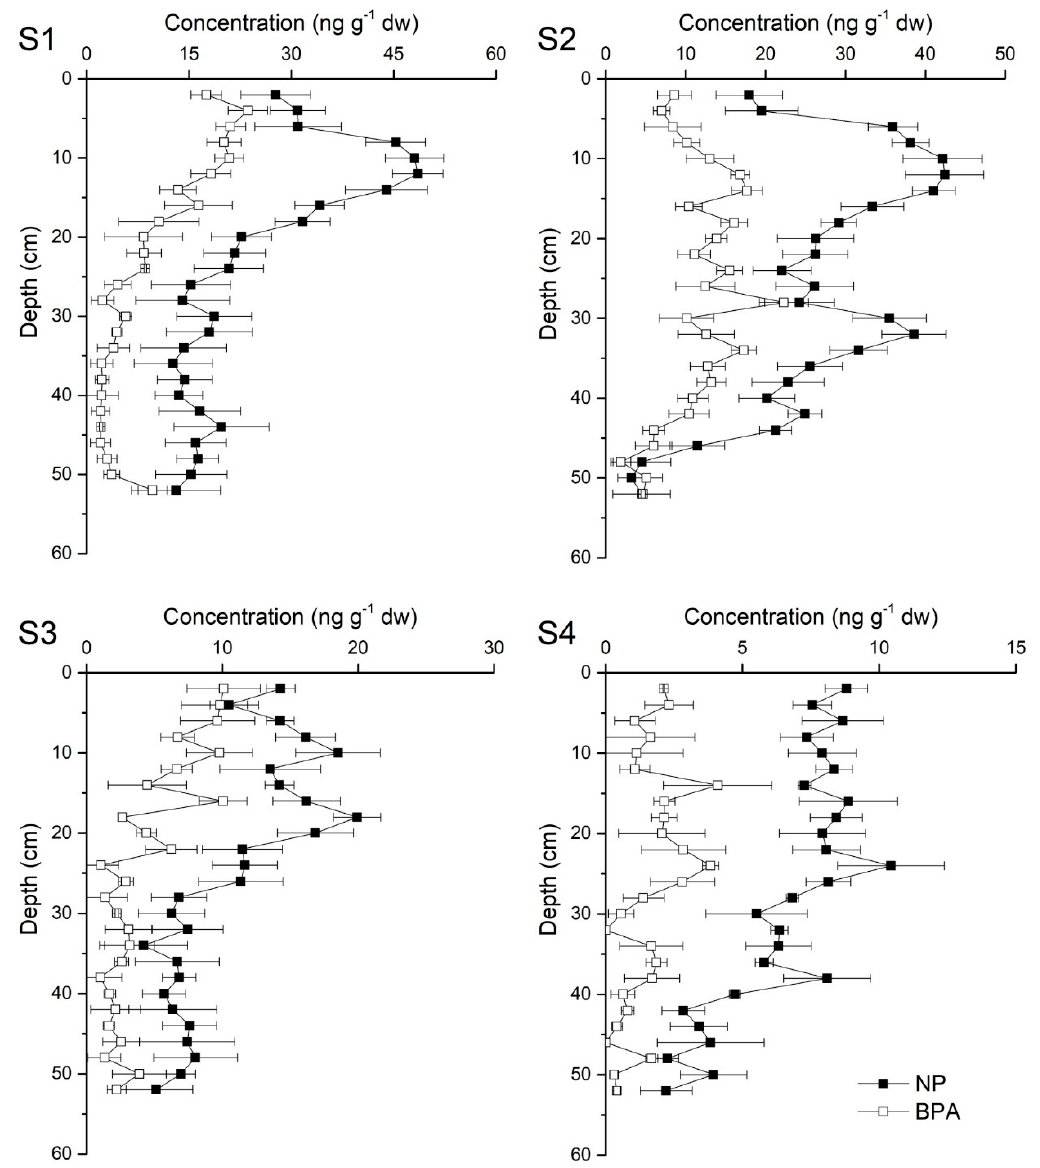
Figure 4. Vertical distributions of NP and BPA concentrations in the study areas. S1-4 present the sampling sites in Figure 1.